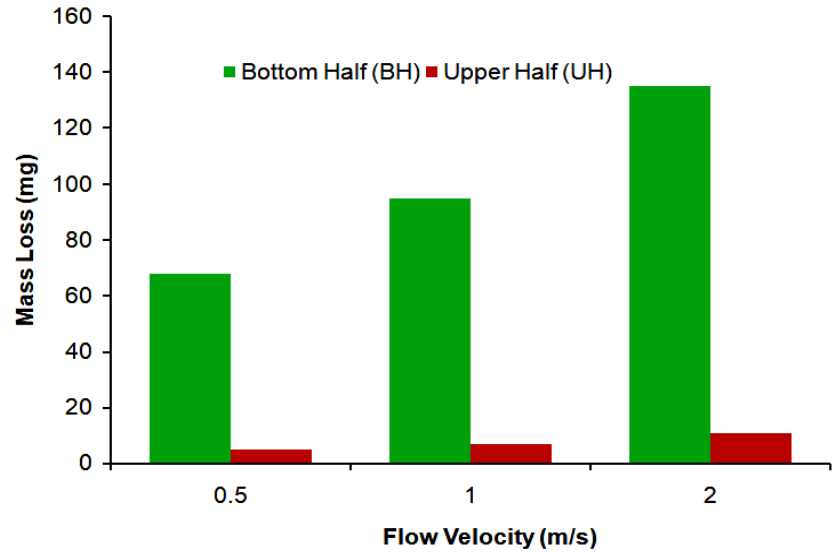
Figure 19. Mass loss in 90-degree AISI 1018 carbon steel BH and UH elbows section after exposure of flow for 60 h.